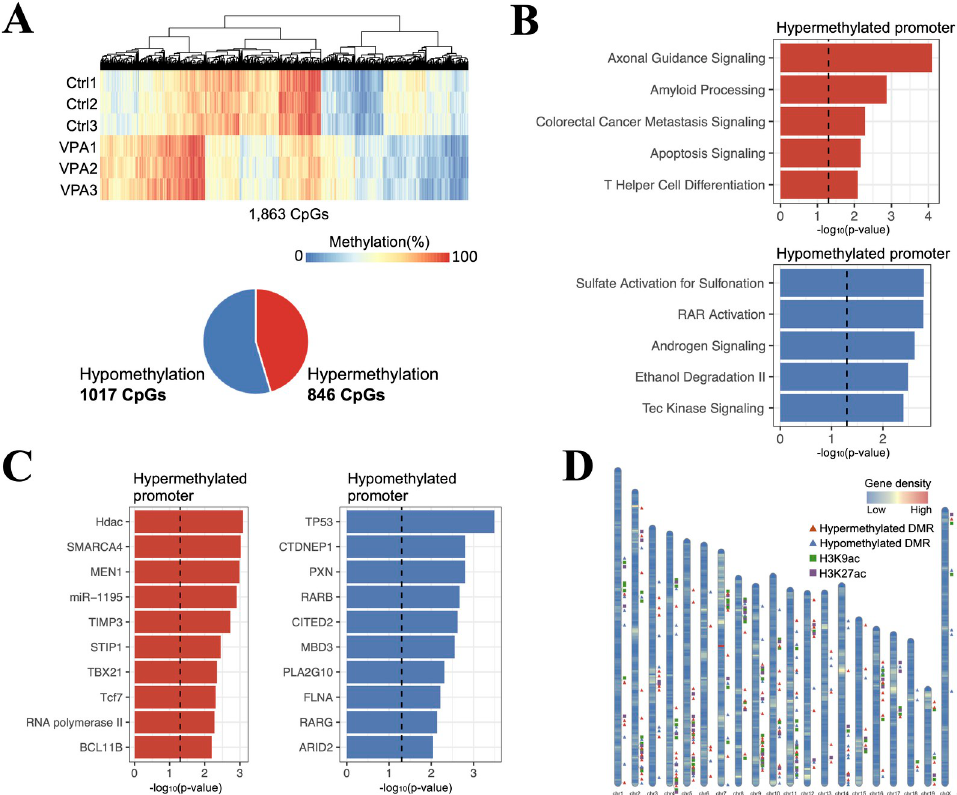
Fig 2. Sperm DNA methylation analysis of VPA-treated mice using whole-genome bisulfite sequencing (WGBS). (A) Heat map showing cytosines in the CpG context that were significantly changed in promoter methylation. The number of significantly hypermethylated and hypomethylated cytosines in the VPA-treated group compared with the control group is shown in the pie chart. P-value < 0.05 by t-test and whose mean methylation rate difference was � 20% were considered significant (n = 3). (B) Top canonical pathways generated by Ingenuity Pathway Analysis (IPA), using the downstream genes of promoters with altered methylation as input. The dashed line indicates − log 10 (0.05). (C) Upstream regulators predicted by IPA, using downstream genes of the promoters with altered methylation as input. (D) Positions of differentially methylated regions (DMRs) found in the VPA-treated group compared with those of the control group are indicated by triangle markers on the ideogram. The positions of acetylated histone H3 (K9 and K27) which have been reported to be present in the vicinity of DMRs ( ± 1 kb) in the male germline are also indicated by rectangular markers on the ideogram. The regions that contained at least 10 CpGs within 300 bp and whose average difference in methylation rate was � 20% were extracted as DMRs. Genomic regions with a score of 50 or higher in the ChIP-Atlas Peak Browser were designated as acetylated histone